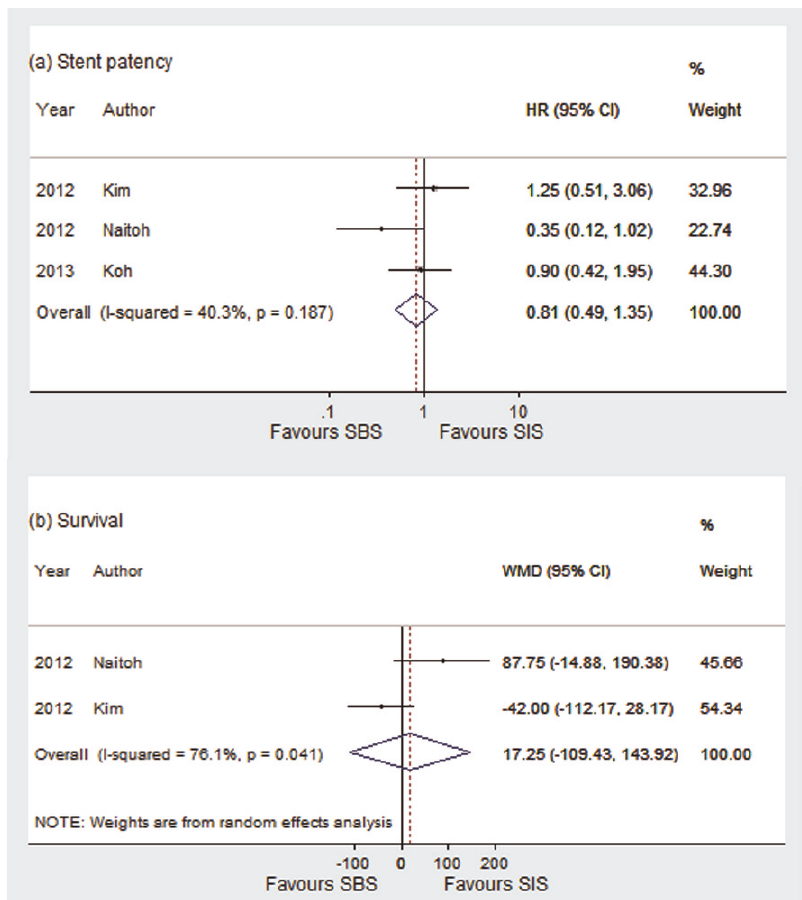
Figure 3 - A comparison of stent patency (a) and patient survival (b) between the SBS and